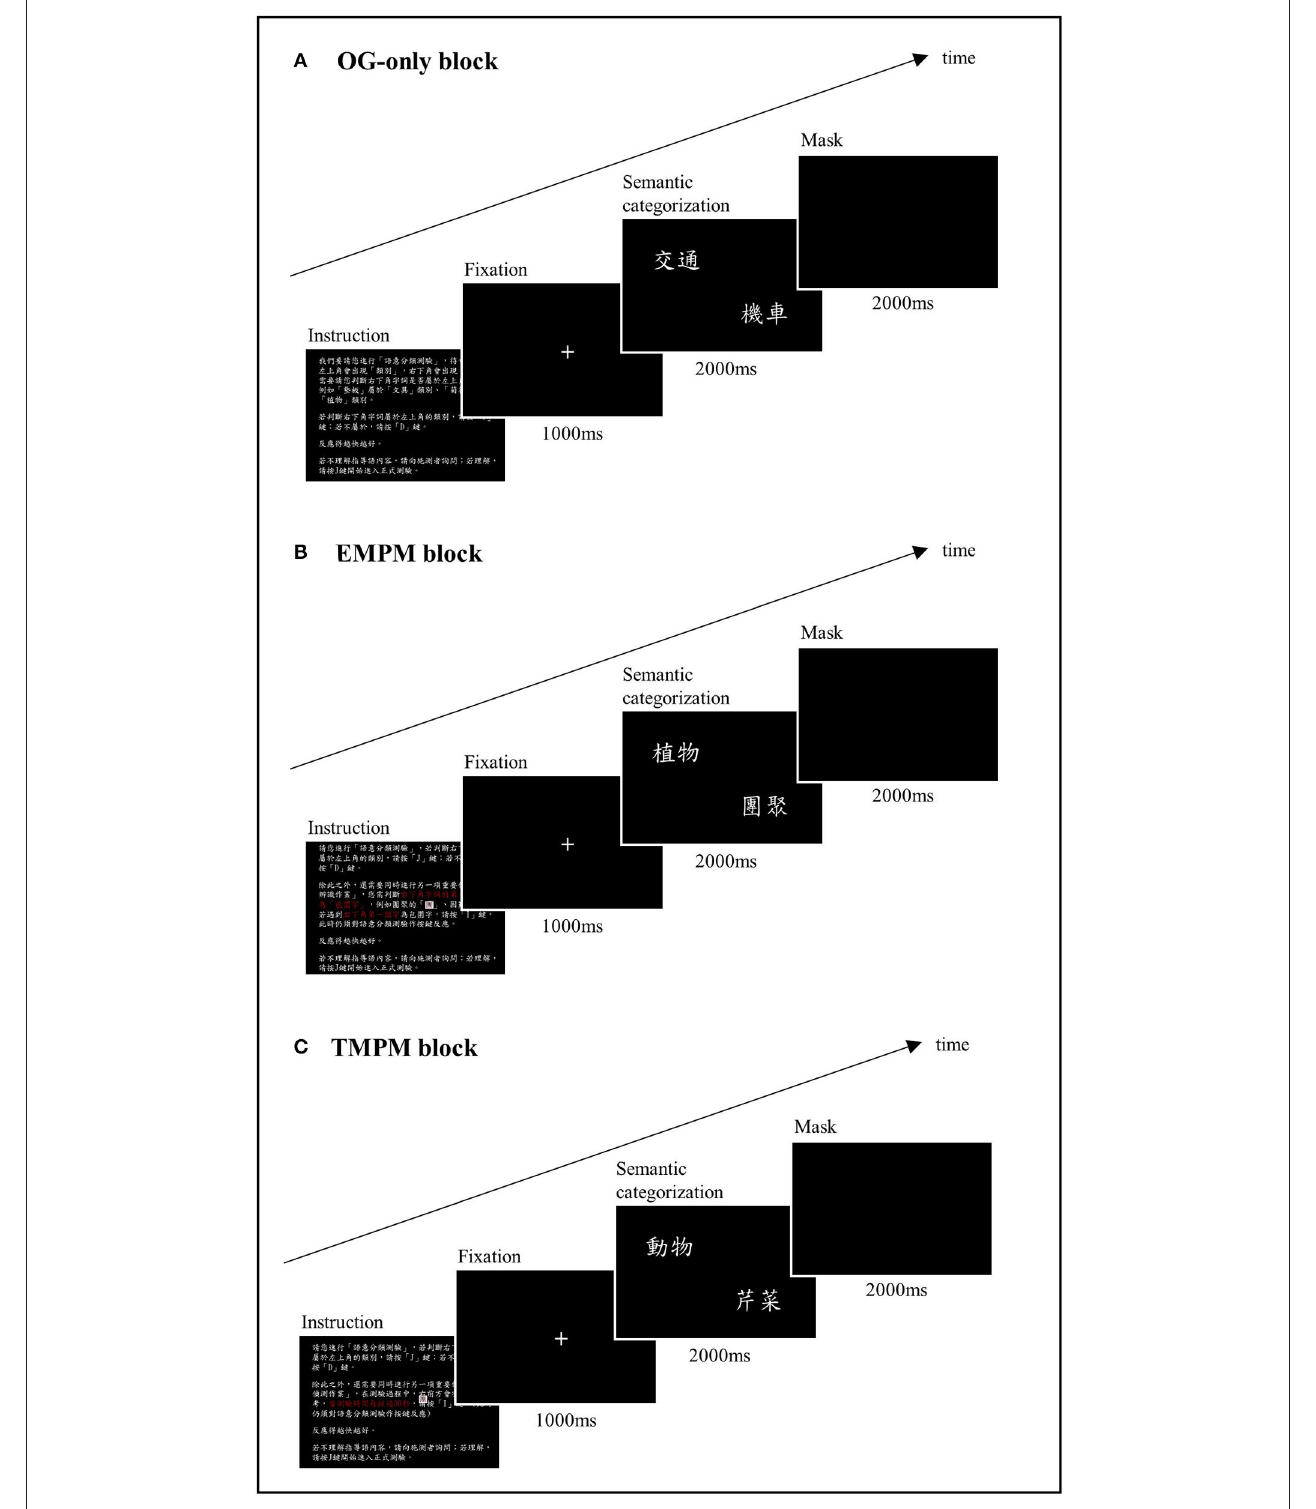
FIGURE 1 | Schema of the computerized prospective memory task. (A) The OG-only block. The participants were instructed to decide if an exemplar presented on the bottom right corner of the screen belonged to the semantic category indicated on the left upper corner of the screen. (B) The EBPM block. The participants were instructed to perform an additional PM task while performing the ongoing task, in which they had to press a designated key when spotting a character that was perceptually enclosed. (C) The TBPM block. The participants were instructed to press a designated key at a 30s interval from the beginning of the ongoing task.